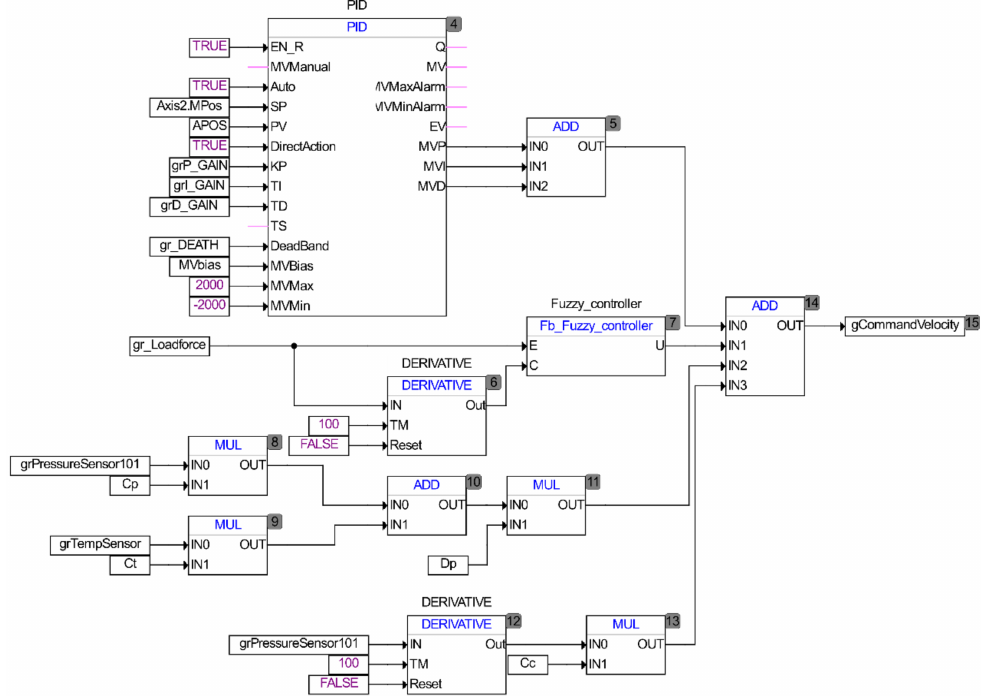
Figure 7. Software part of experimental platform.